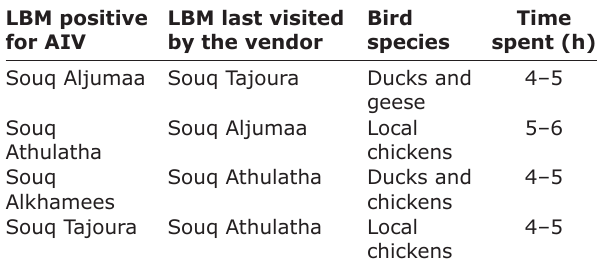
Table-5: Movement of poultry vendors between LBMs. Table-4: Logistic regression analysis of risk factors for